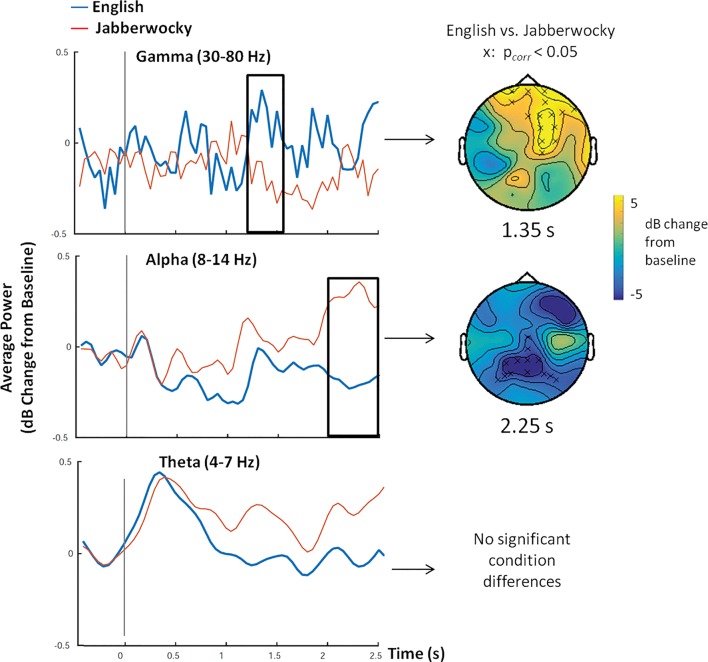
Oscillatory Power. Time series of oscillatory power for gamma (30–80 Hz), alpha (8–13 Hz) and theta (4–7 Hz) frequency bands over time, averaged over all electrodes for English (blue) and Jabberwocky (red) sentences. The head maps show topographical results (at a time point that was determined to be representative of the whole window based on visual inspection) of the cluster-based permutation test where a significant difference (x denotes pcorr < 0.05) between conditions was observed for gamma and alpha frequencies only. In gamma, significantly more connectivity was seen for English sentences between 1.25 and 1.55 s that was largest at frontal electrodes. In alpha, significantly less connectivity was seen for English sentences between 2 and 2.65 s that was largest at frontal and posterior electrodes. In theta, a large increase in oscillatory power was seen for both English and Jabberwocky directly after sentence onset (0 ms), with no significant condition differences (p > 0.10).